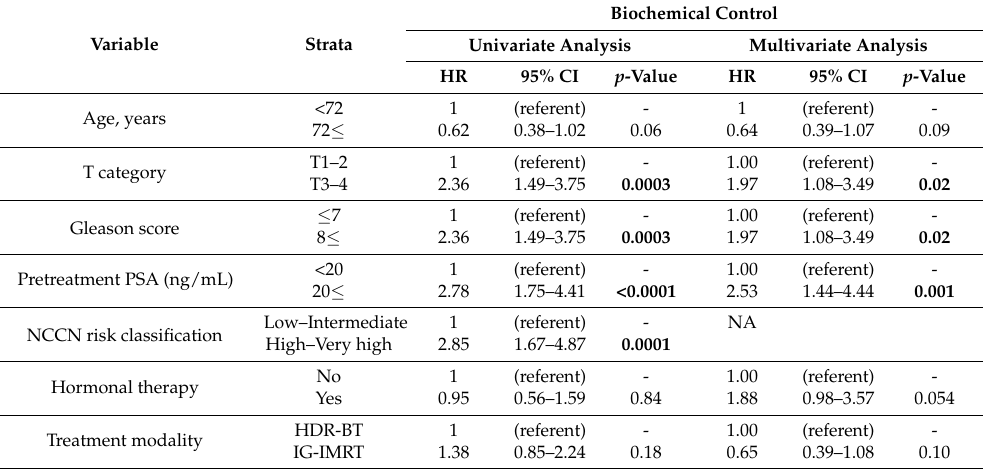
Table 3. Univariate and multivariate analysis for biochemical control rate using Cox proportional hazards